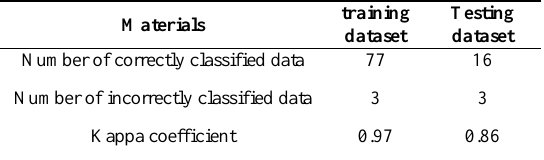
Table 5. Results of proposed model with 5 layers in MLP.